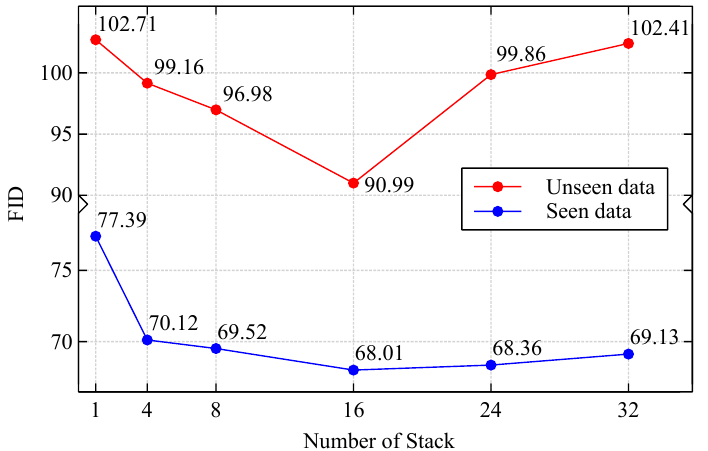
Figure 5. FID vs. number of stacked